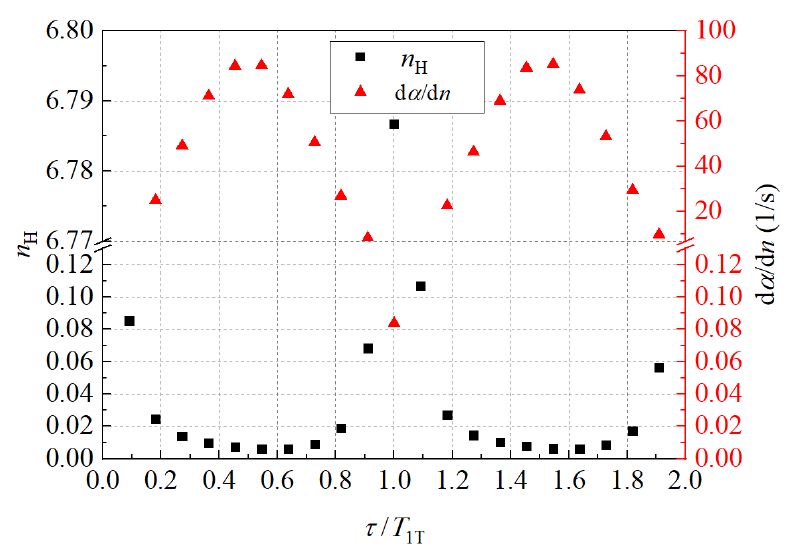
Figure 8. Evolutions of the value of n H when the thermoacoustic mode is marginal stable (correspond- ing to the left vertical axis) and d α /d n (corresponding to the right vertical axis) with the normalised time delay τ / T 1T for the linear stability of the first transverse